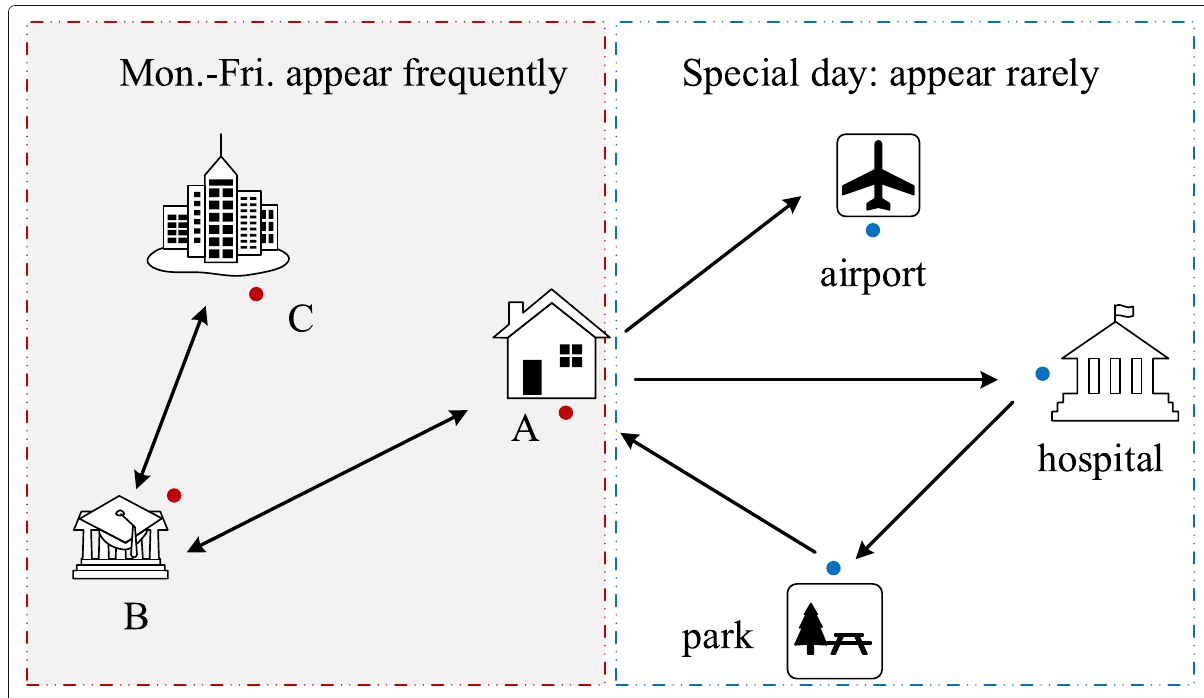
Fig. 1 The location privacy leakage caused by the malicious users